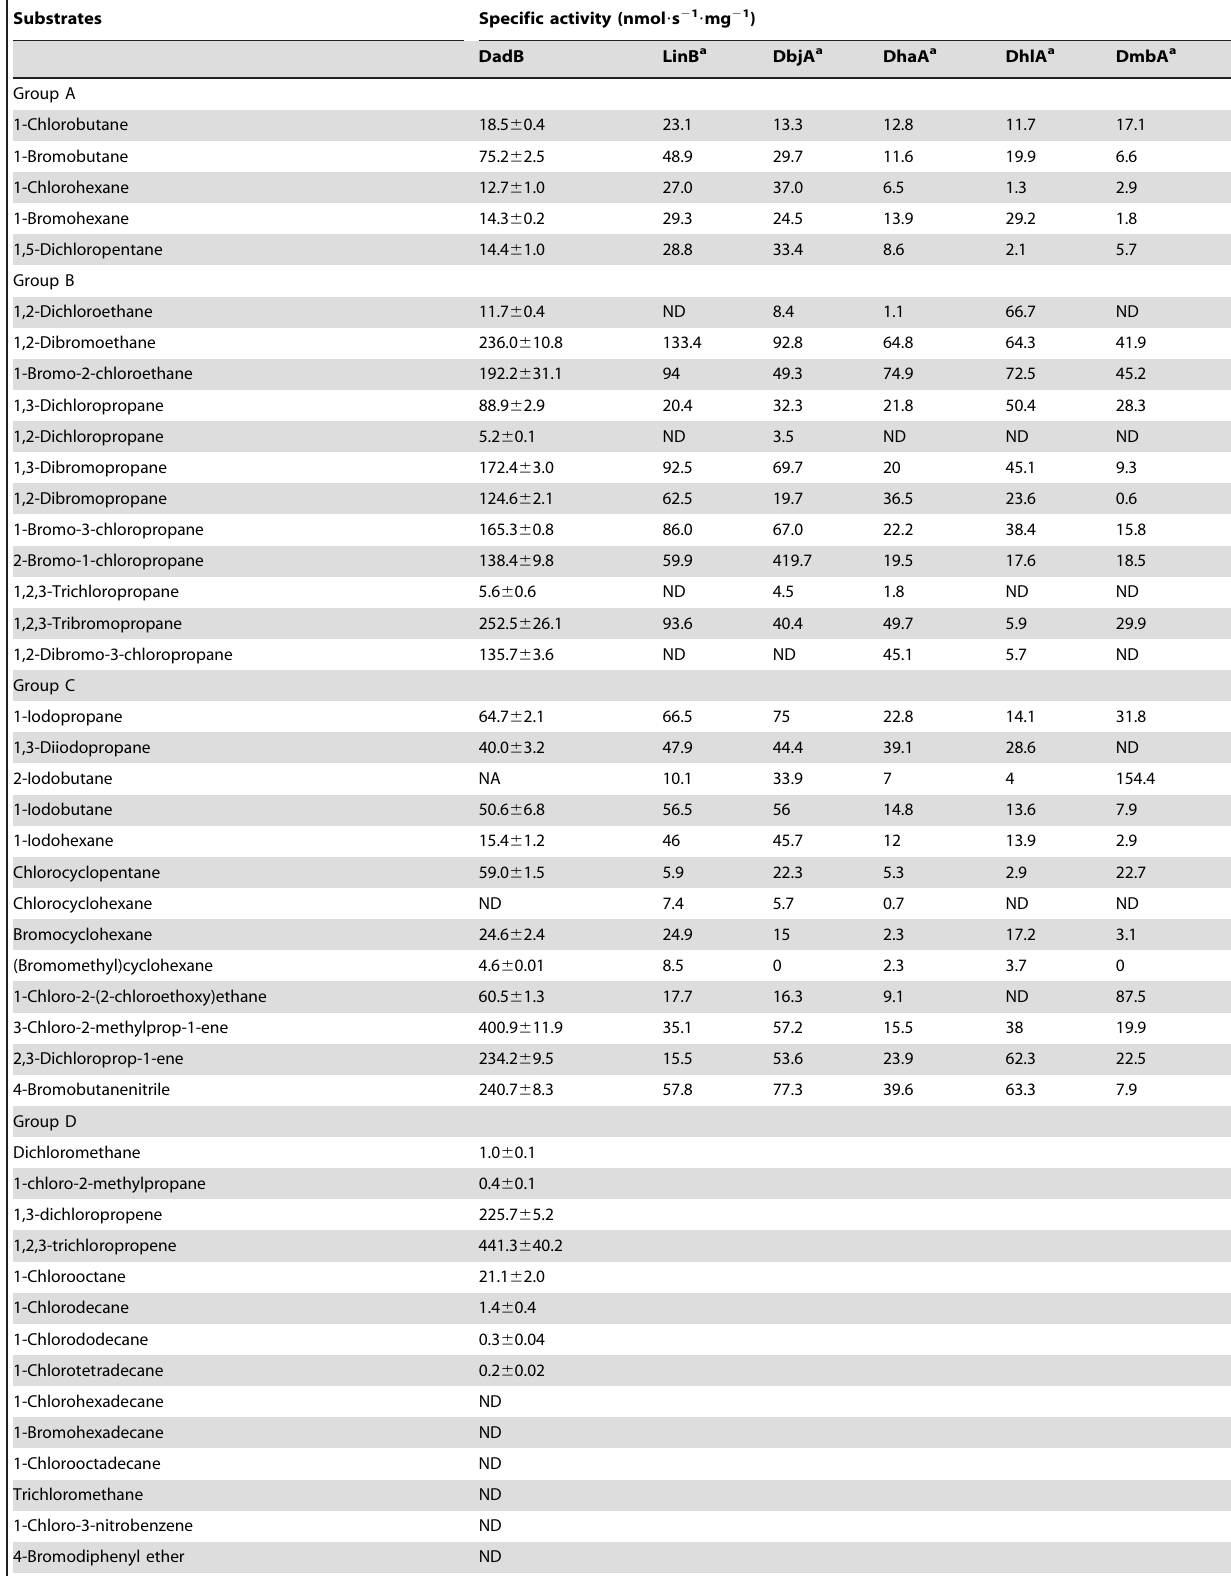
Table 1. Specific activity (nmol ? s 2 1 ? mg 2 1 ) of DadB and comparison with other HLDs.